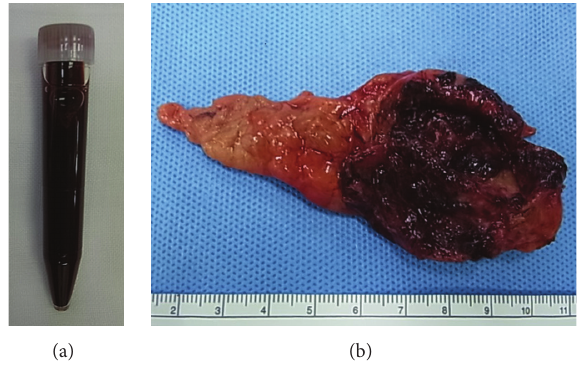
Figure 4: Photographs of (a) the blood-stained fluid from the cyst and (b) surgical specimen of the left adrenal gland including the remaining cyst